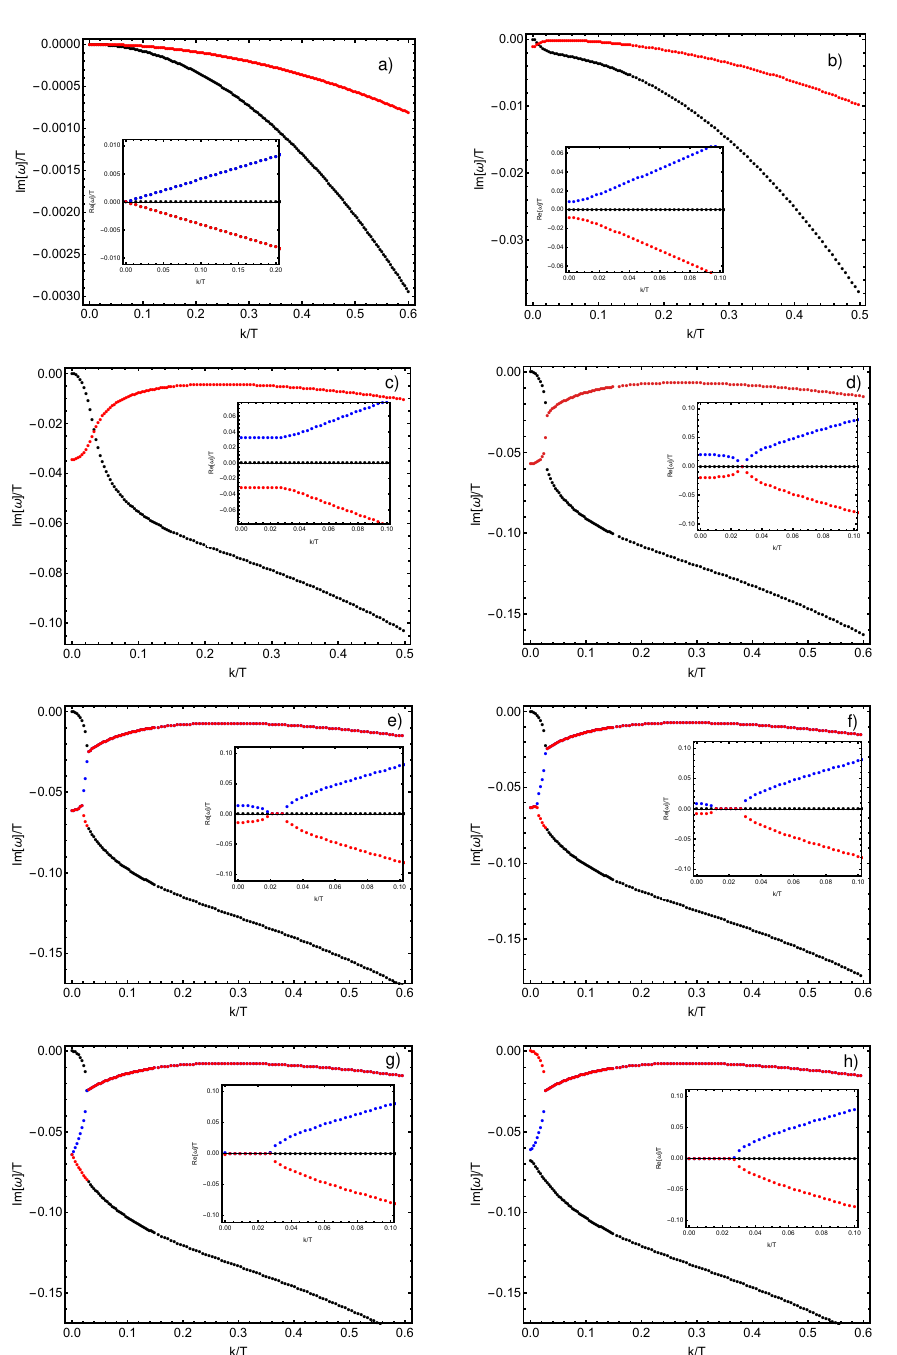
Figure 22 . The lowest modes in the longitudinal sector for (cid:11) = f 0 ; 0 : 1185 g ; m=T = 0 : 1 and (cid:12) = 5. The EXB strength increases from panel a) to panel h). In panel a) the crystal di(cid:11)usion mode is shown in black color. Increasing further the EXB, the damping of the black mode in panel h) becomes larger and